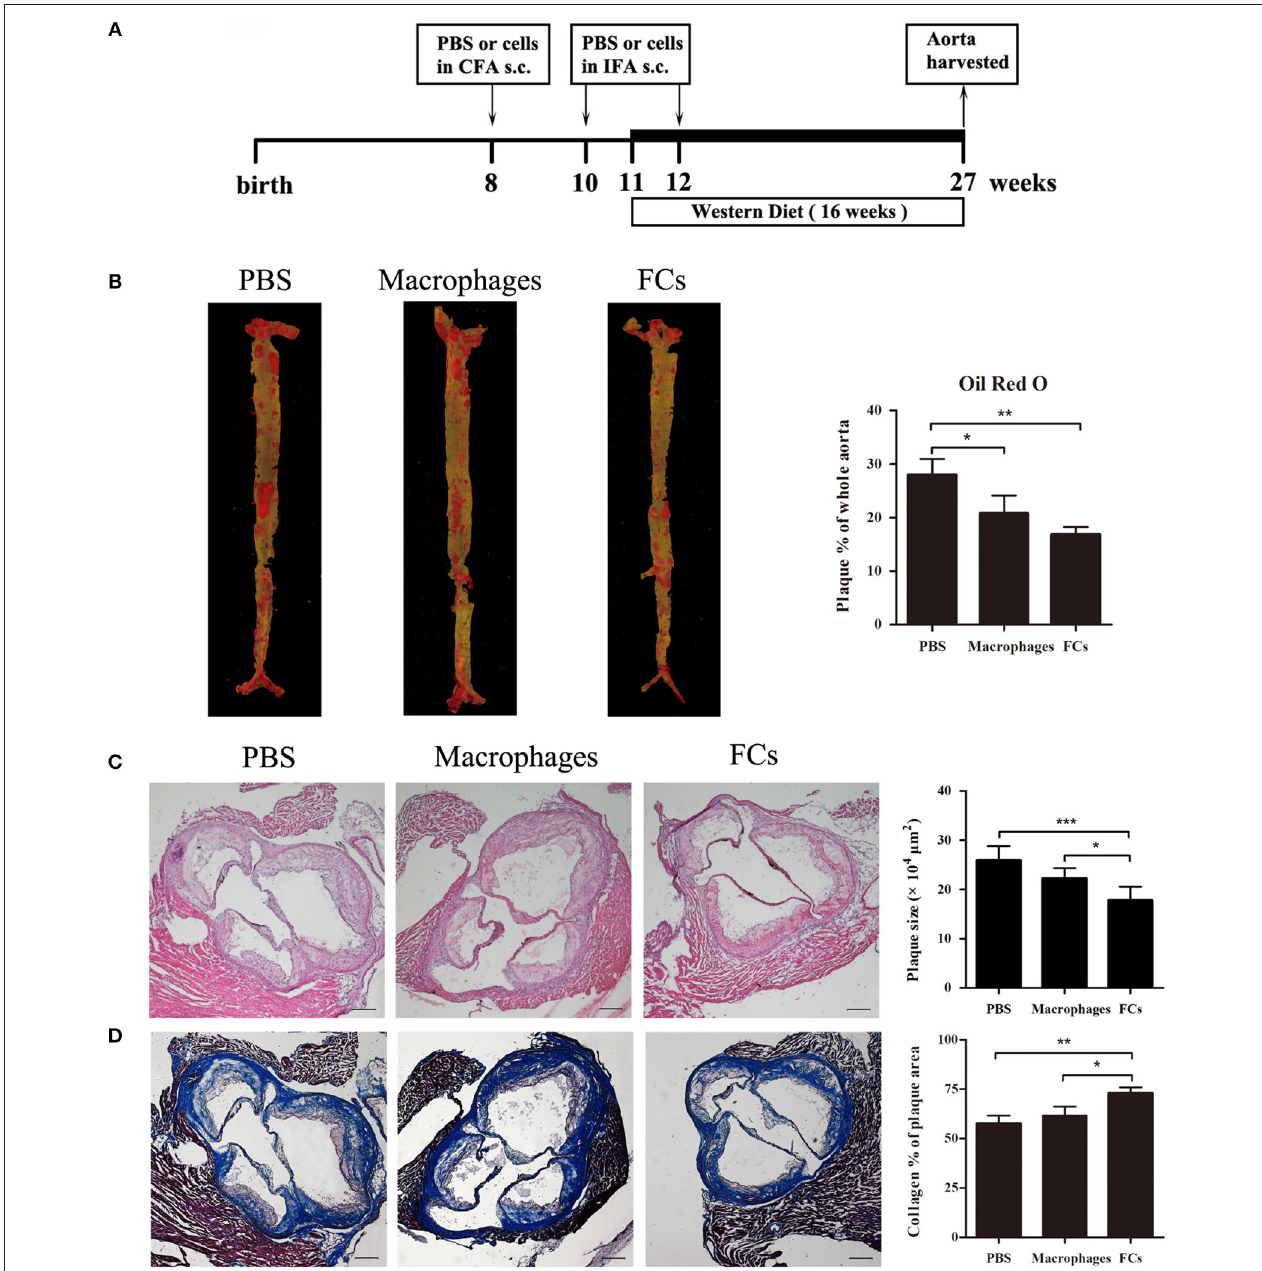
FIGURE 2 | FCs immunization attenuates initial atherosclerotic lesion. (A) Schematic illustration of the prevention experimental setup. (B) Evaluation of en face lesion size of the whole aorta was carried out by Oil Red O staining. (C) Plaque size in the three-valve area of the aortic root was assessed by hematoxylin and eosin staining. (D) Collagen content in the aortic root was determined by Masson’s Trichrome staining as the percentage of the total lesion area. Scale bars, 200 µ m. All data are presented as mean ± SEM and are representative of all mice. n = 5–6 in each group; * p < 0.05; ** p < 0.01; *** p < 0.001.